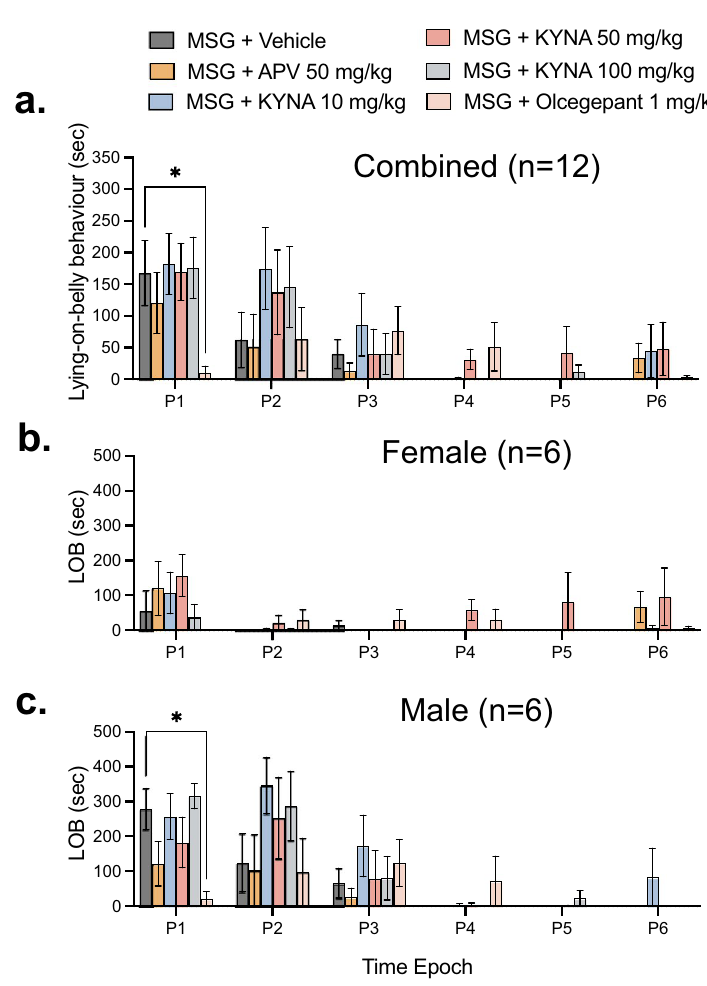
Figure 3. Olcegepant attenuated MSG-induce nausea behaviours in male rats. Comparison of the effect of MSG (1000 mg/kg; i.p.) alone with APV (50 mg/kg; i.p.), KYNA (10, 50, 100 mg/kg; i.p.) and olcegepant (1